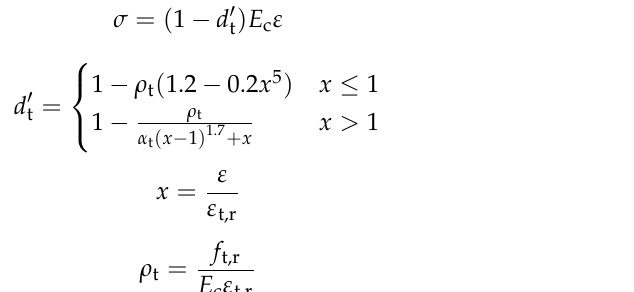
f is f f f , tk or tm in dif-